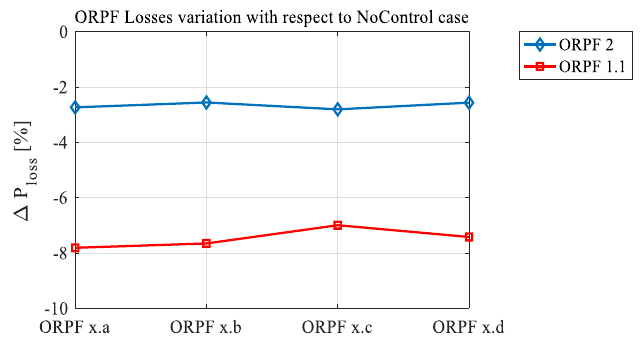
Figure 23. ORPF 1.1 and ORPF 2 relative power losses with respect to the initial case.